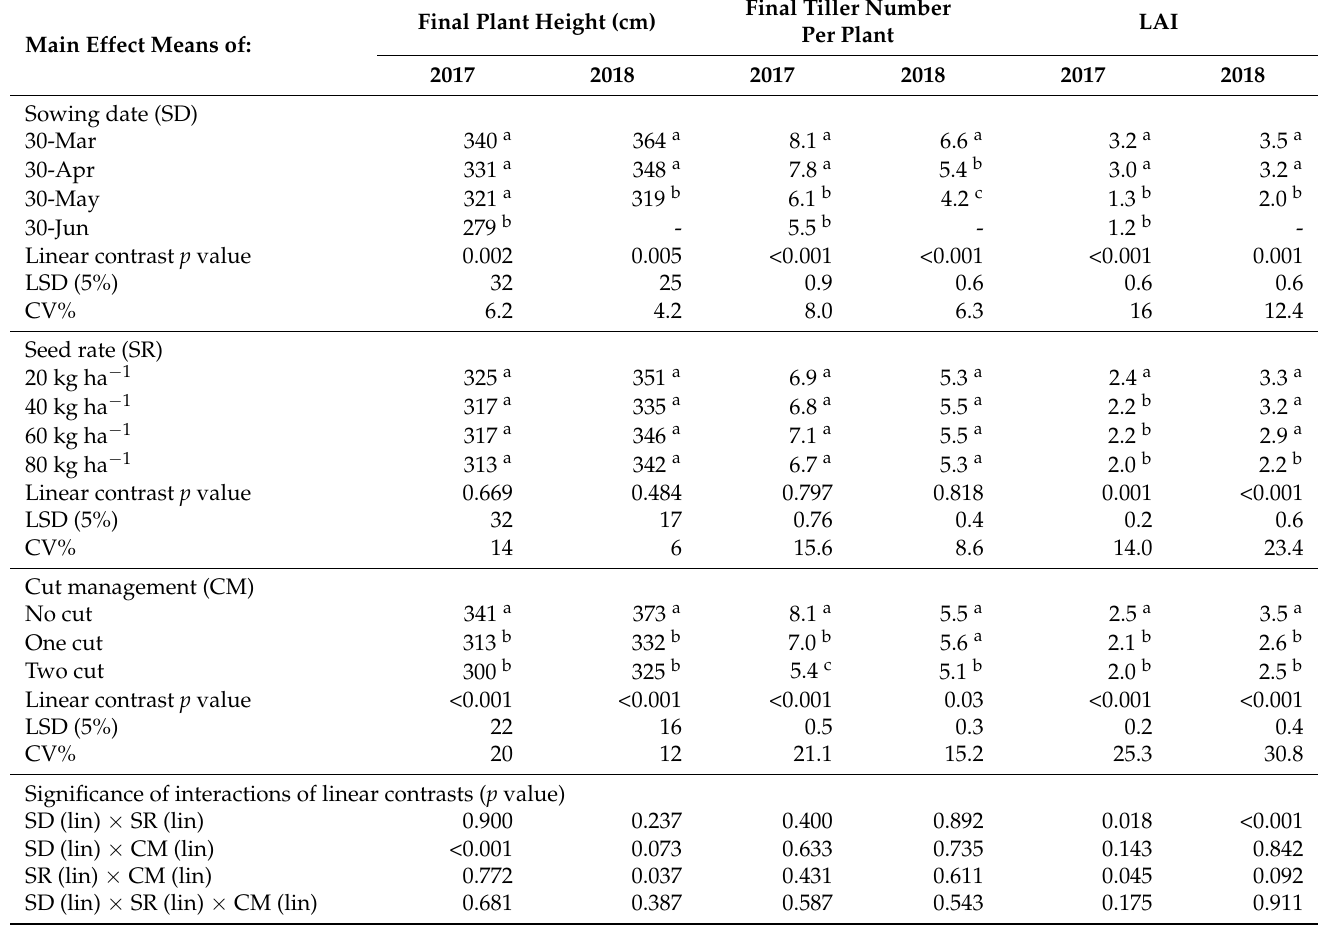
Table 1. Main effect means of sowing date, seed rate and cutting management on plant properties of teosinte in 2017 and 2018 at NCRP, Chitwan,